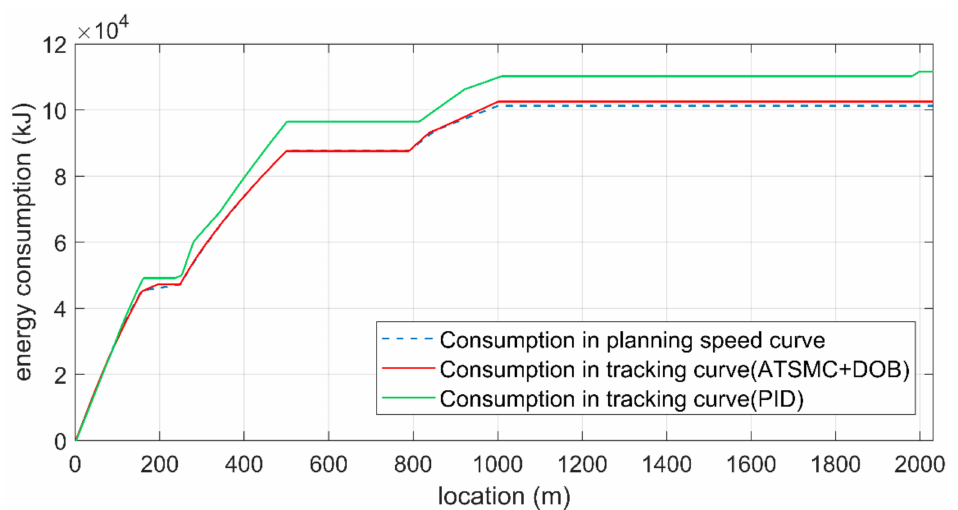
Figure 22. Experiment 1 and Experiment 2.